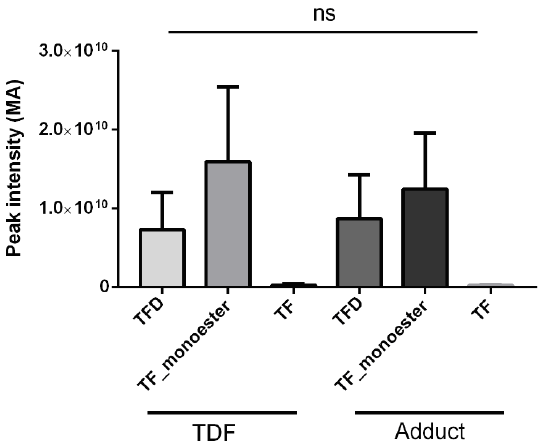
Figure 6. TDF- and 1P4-TFD -derived metabolites formed in MT-4 cells after 4 h of incubation. Cell extracts were prepared following incubation with 1 μ M each of TDF or 1P4-TFD (adduct) and in- tracellular metabolites, determined by LC-MS/MS. Shown are the levels of TFD, TF_monoester, and tenofovir base (TFV). Data for the graphs are means of three independent experiments (six runs/measurements per experiment) ± SD. No significant (ns) differences between the compounds could be detected in either the spectrum or amount of the metabolites ( p = 3; one-way ANOVA and Tukey’s post hoc test).